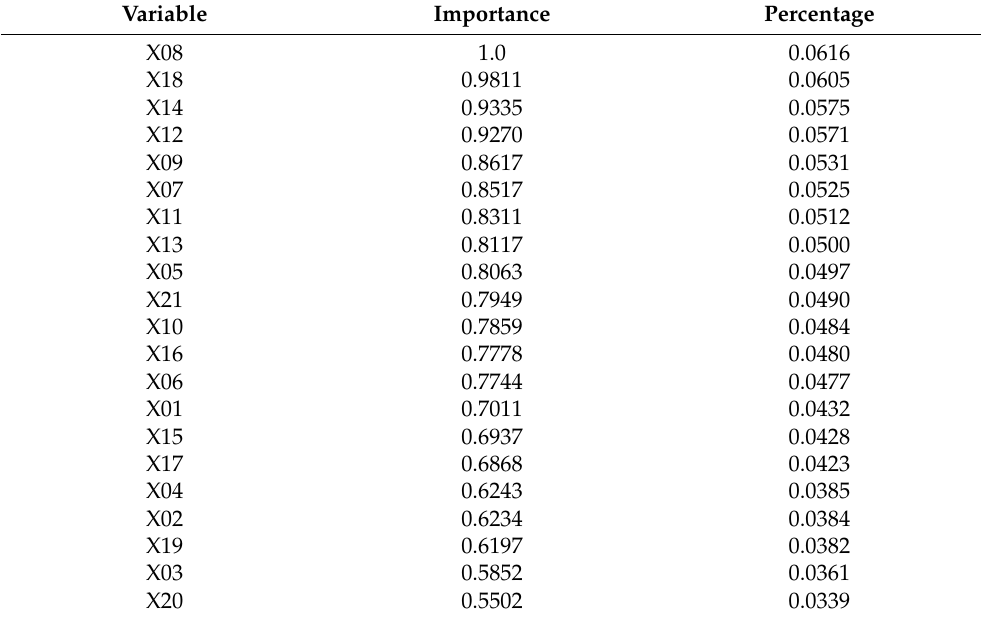
Table 6. Parameters of the generated model—age assessment for